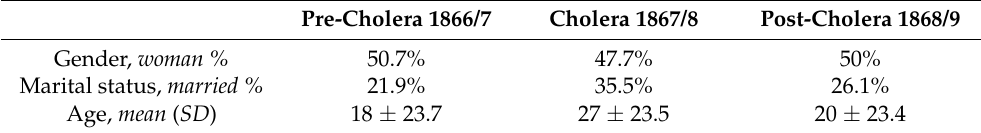
Table 3. Baseline